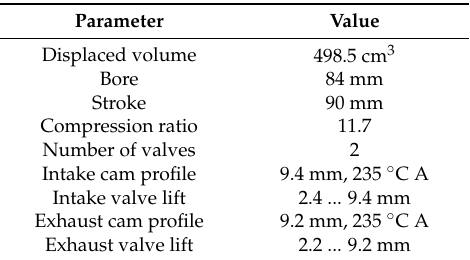
Table 1. Research engine